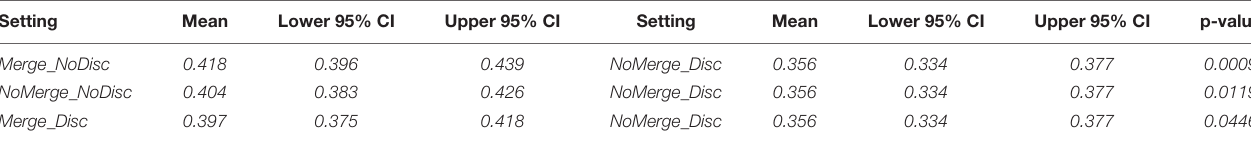
FIGURE 7 | Fixation data output as the velocity threshold is modified. The angular velocities of the eye movements (vertical axis) are captured over several seconds of natural viewing behavior (horizontal axis) and the horizontal bars above the graphs signify the chains of gaze points that are classified as fixations. TABLE 4 | Spearman R of TFD – mean values and confidence intervals of settings of merging adjacent fixations and discarding short fixations, and significantly different pairwise comparisons based on Tukey HSD